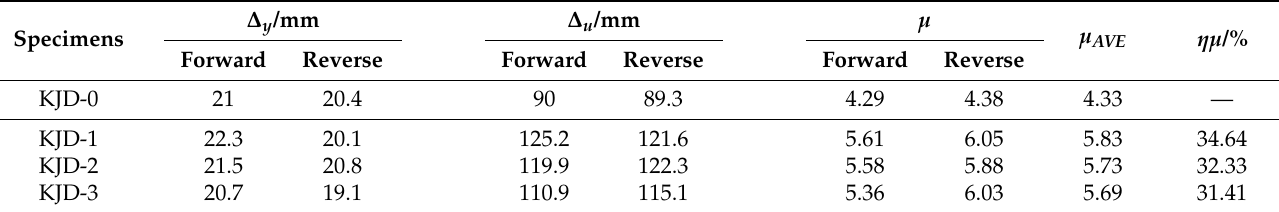
Table 5. Comparison between mean P max and Δ u.